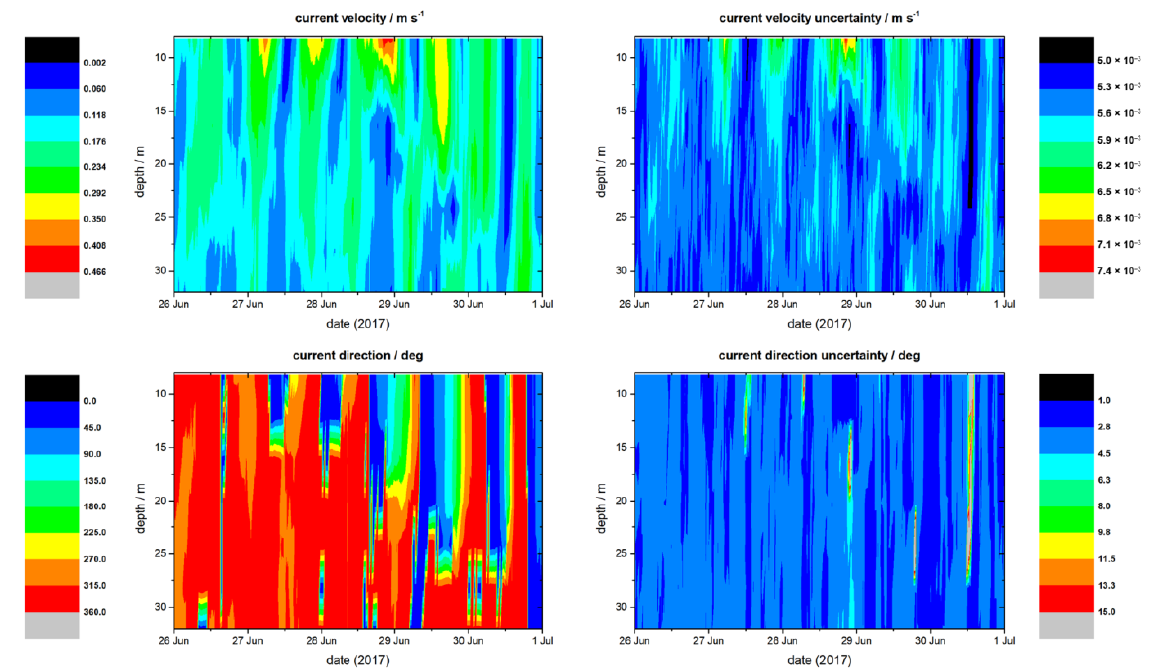
Figure 18. Corrected velocity modules and their standard uncertainty vs time (first row) and corrected velocity directions and their standard uncertainty vs time (second row).